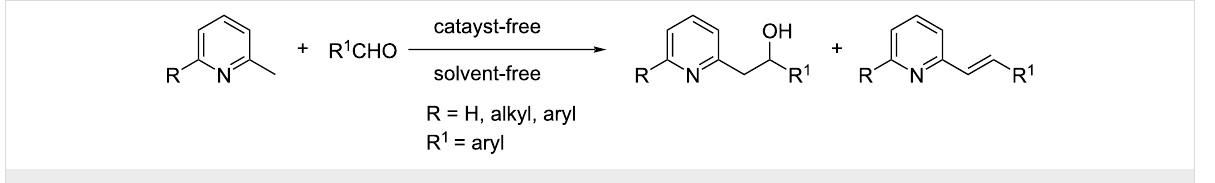
Scheme 3: Our work: catalyst- and solvent-free benzylic addition of aldehydes to